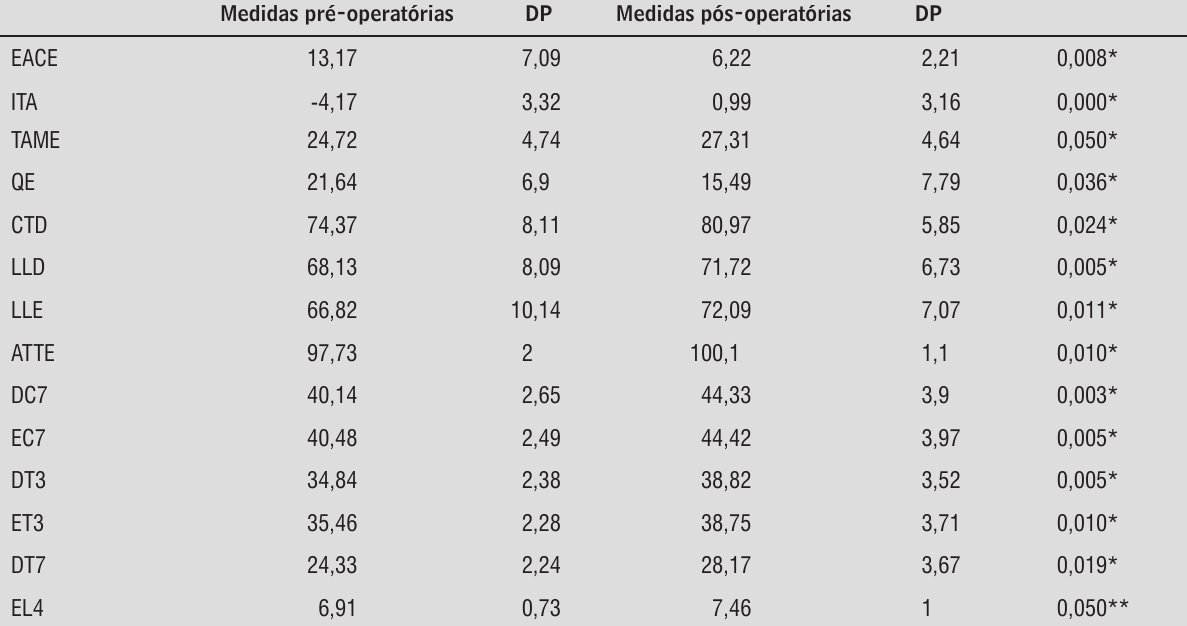
Perdriolle R. A escoliose: um estudo tridimensional. São Paulo: Summus;